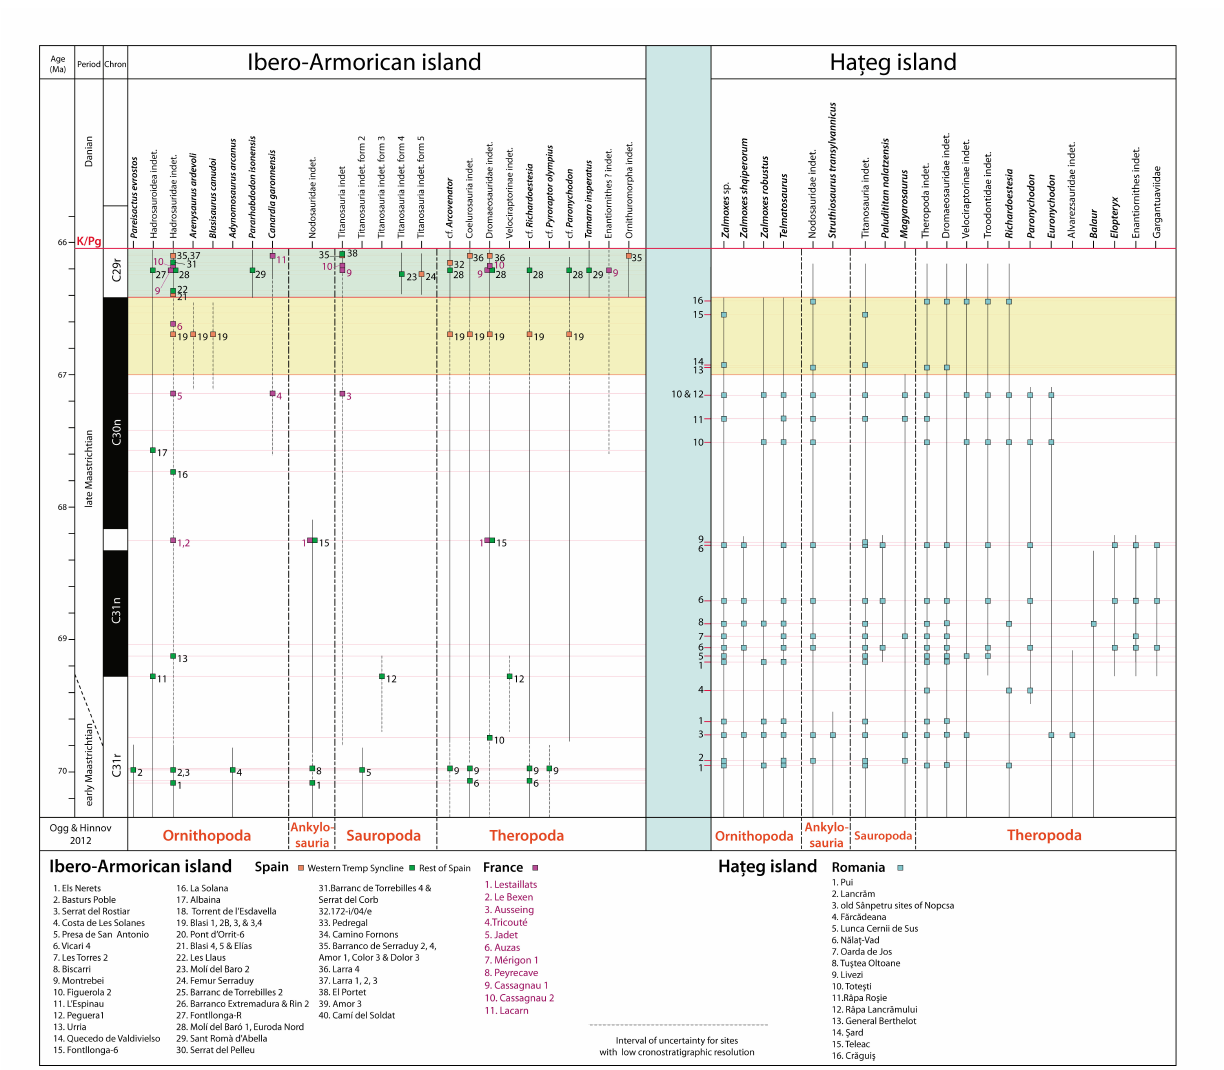
Figure 8. Dinosaur groups and species occurrences in the Ibero-Armorican island and Ha¸teg island during the late Maastrichtian. Ha¸teg island data are based on [32] with updated information. The yellow band marks the temporal interval used for comparison, whereas the green band marks the last ≈ 350 ka of the Maastrichtian, with a record only in the Ibero-Armorican island. Magnetochronostratigraphic scale based on [153] and calibration for the K-Pg boundary based on